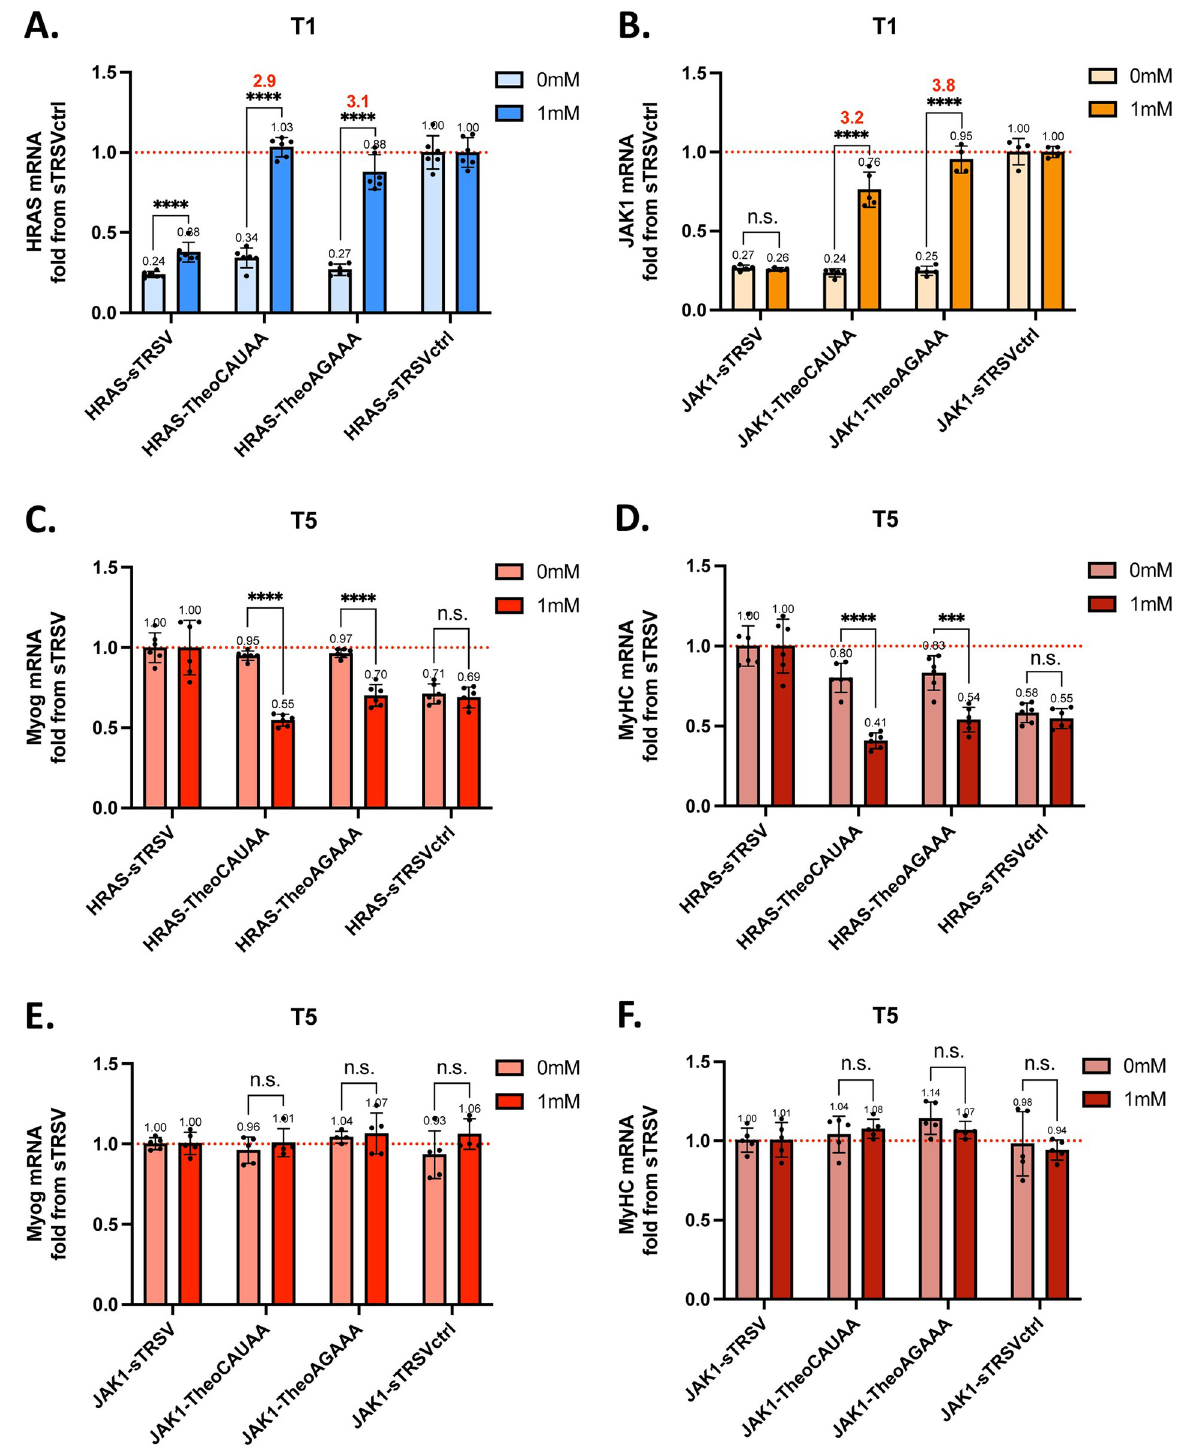
Fig 4. HRAS-based RNA controllers exhibit theophylline-dependent inhibition of myoblast differentiation. A. Real-time RT-qPCR detection of HRAS expression one day after transient transfection of HRAS constructs. B. Real-time RT-qPCR detection of JAK1 expression one day after transient transfection of JAK1 constructs. C. Real-time RT-qPCR detection of Myogenin five days after transient transfection of HRAS constructs. D. Real-time RT-qPCR detection of MyHC five days after transient transfection of HRAS constructs. E. Real-time RT-qPCR detection of Myogenin five days after transient transfection of JAK1 constructs. F. Real-time RT-qPCR detection of MyHC five days after